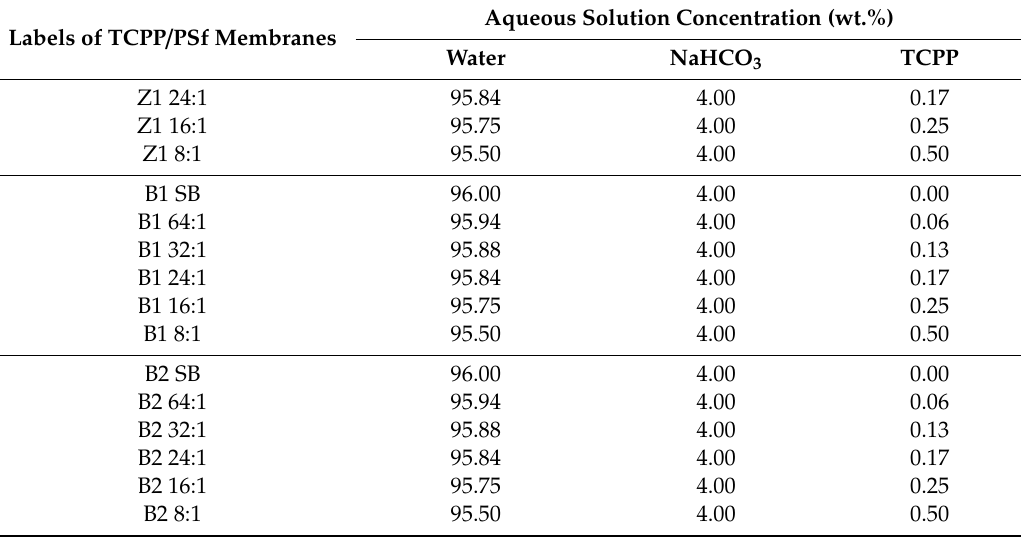
Table 2. Labels of TCPP / PSf membrane and corresponding aqueous solution concentration. Labels of TCPP / PSf